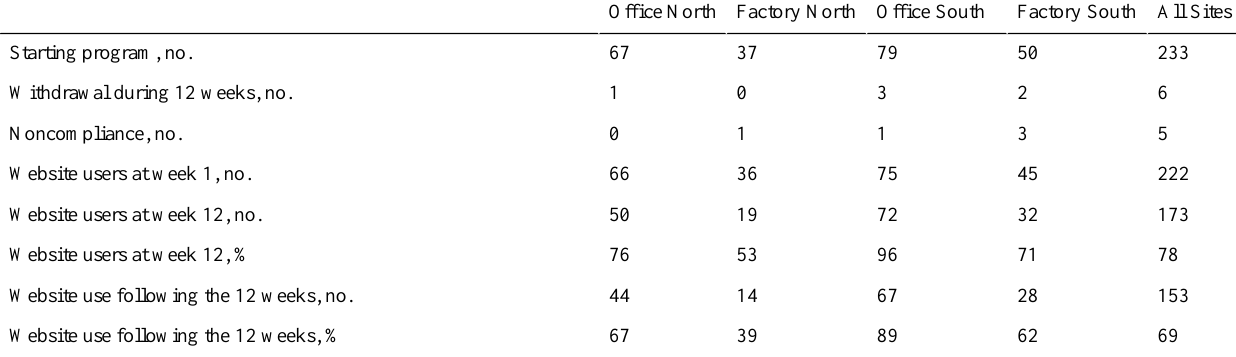
Table 2. Employee website use during and following the 12-week study, by work